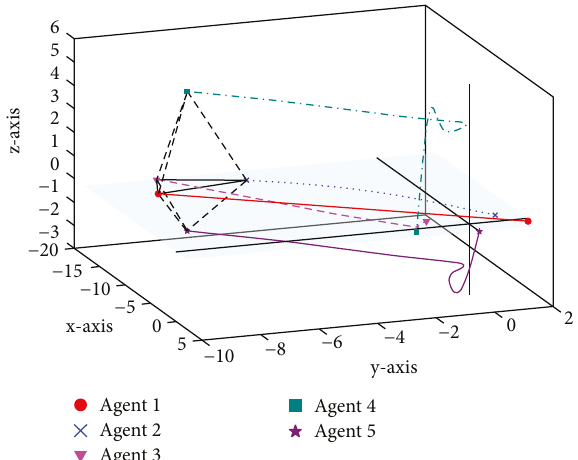
Figure 7: Trajectories of agents in a 3D space: the velocity of the leader agent is in the initial coplanar plane.